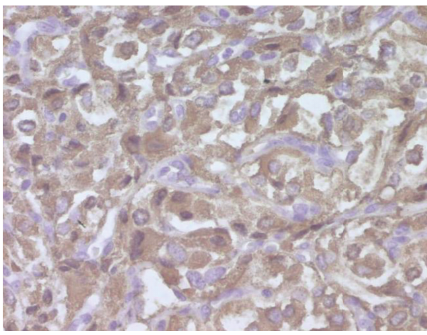
Figure 5: (Synaptox400) the cells show a strong cytoplasmic